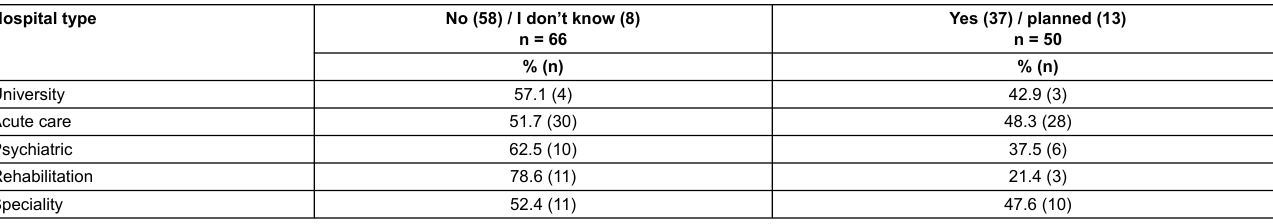
Table 5: Comparison within hospital types on whether a guideline exists (n =